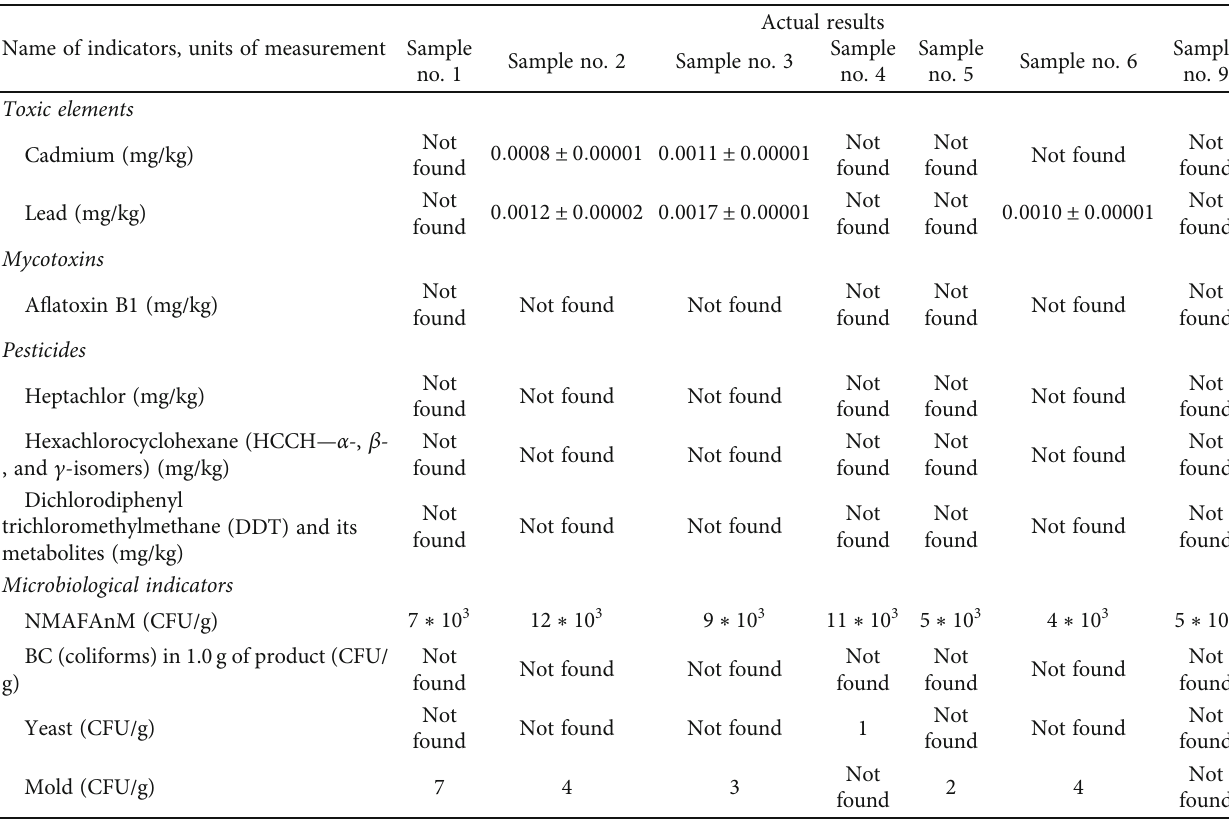
Table 10: Safety indicators of assortments of